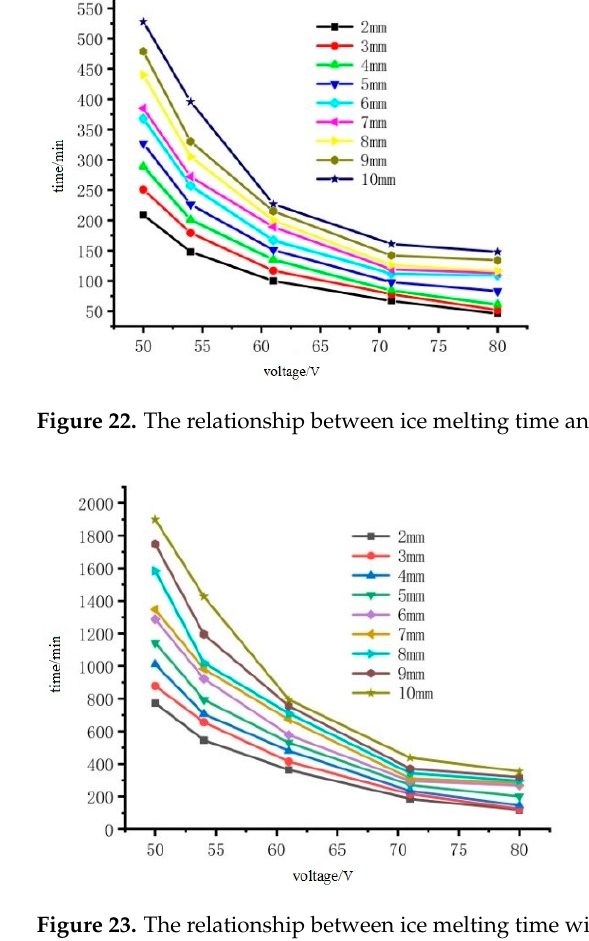
Figure 23. The relationship between ice melting time without heat insulation and input voltage.